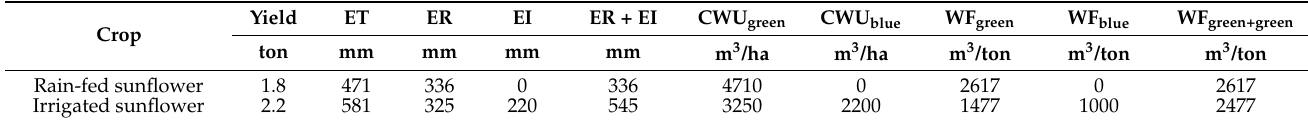
Table 2. Water use for sunflower